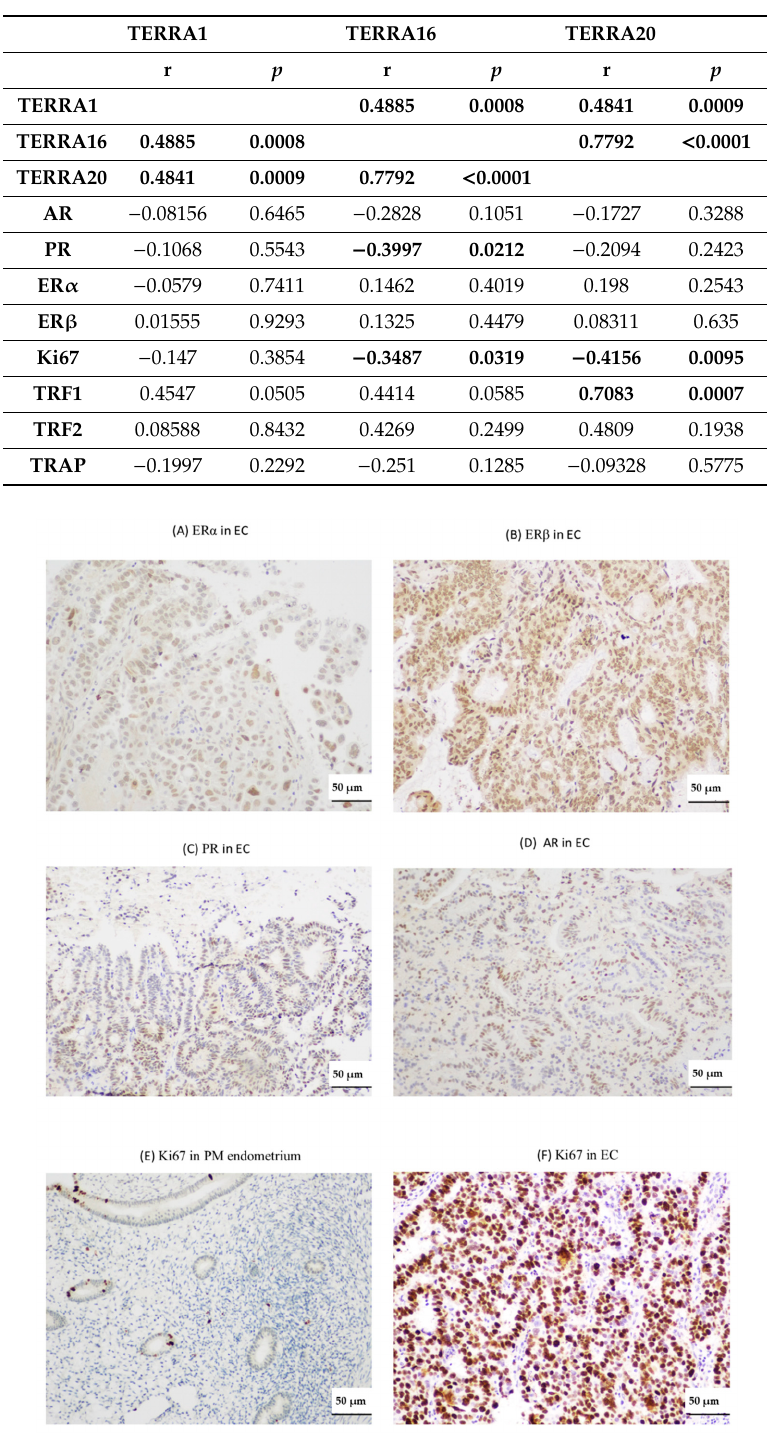
Table1. Correlationofchromosomes1q-2q-4q-10q-13q-22q(TERRA1),TERRA16TERRA20,LESQSscores for AR, PR, ER α and ER β and immuno-scores for Ki67, TRF1, TRF2 and TA measured by TRAP assay in all endometrial samples. Values in bold letters show significant correlations